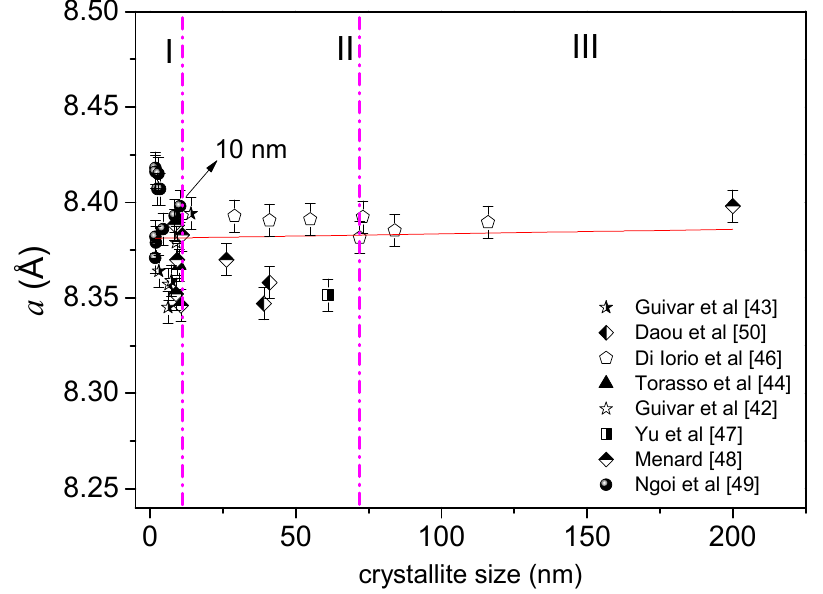
Figure 2. Lattice parameter a (Å) vs. crystallite size (nm) for several Fe-oxide NPs prepared by co-precipitation. Figure developed by the authors.